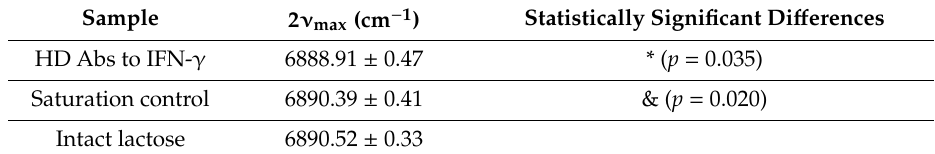
Table 2. Results of FTIR spectroscopy: the position of the maximum of the absorption band of the first overtone of intramolecular stretching vibrations of water molecules 2 ν max in the NIR spectra of aqueous solutions of the analyzed lactose samples 1